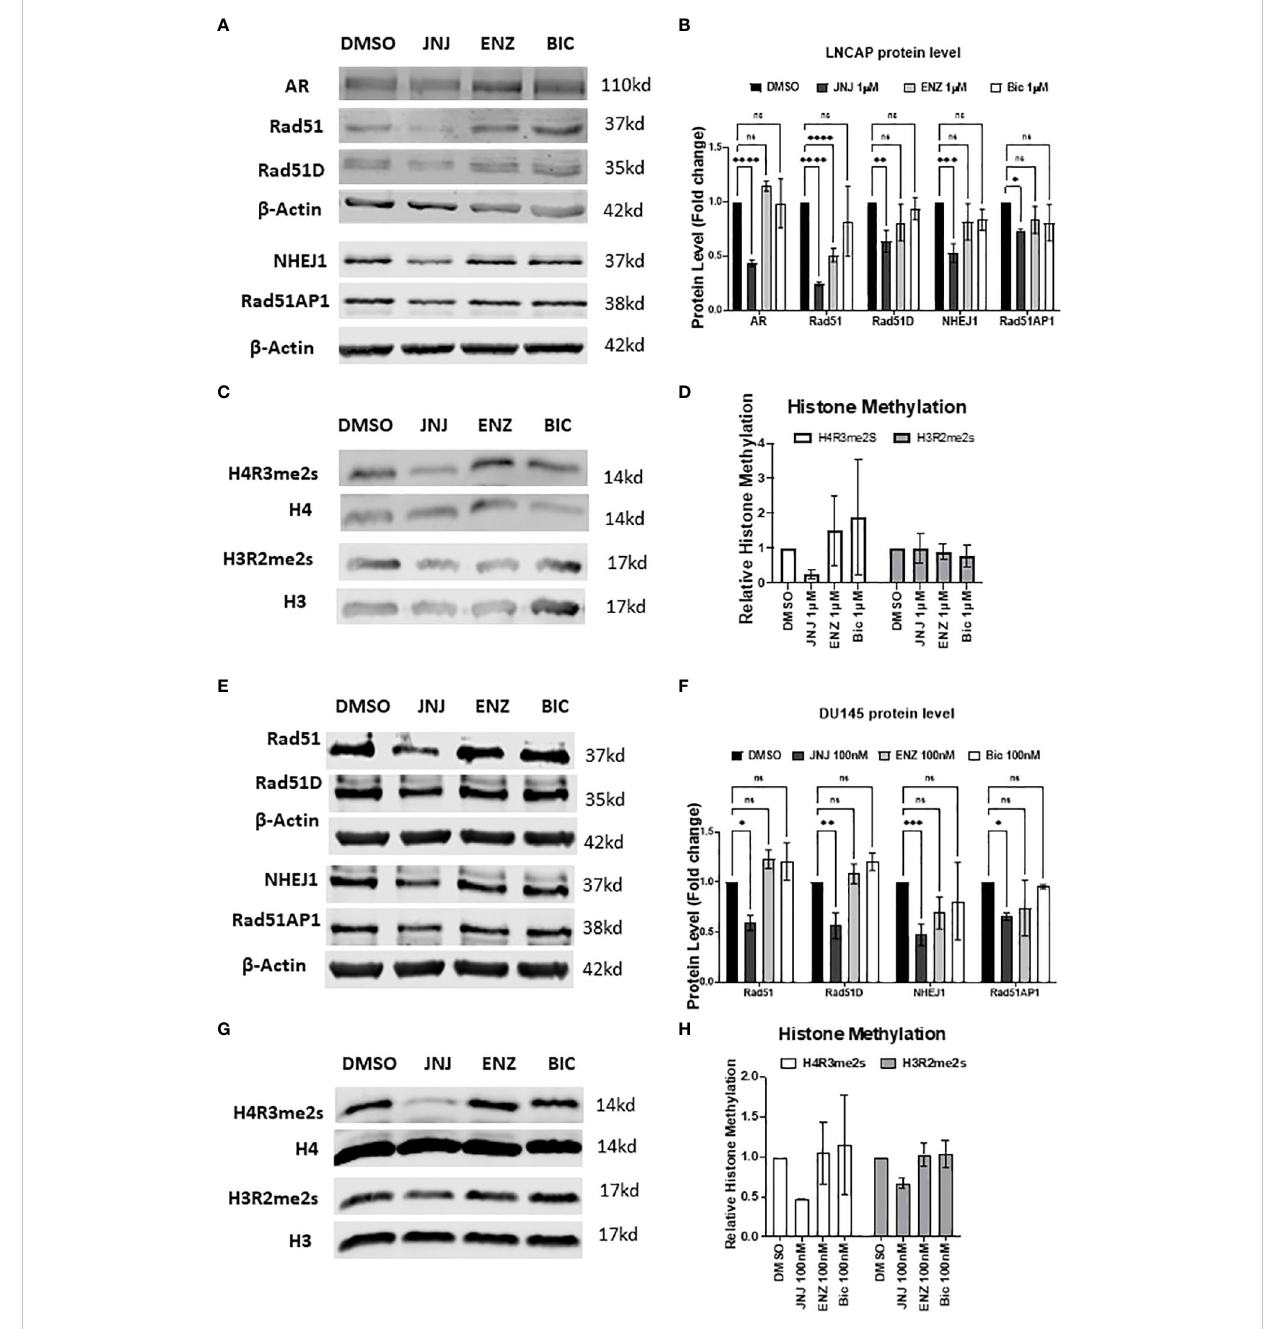
FIGURE 2 JNJ-64619178 targets DNA damage repair proteins expression and epigenetic methylation of histone proteins. (A) Representative western blot images showing the change in DNA damage repair proteins expression level compared with standard ASI, Enzalutamide (Enz), and Bicalutamide (Bic) after 4 days of treatment in LNCaP cells. (B) Histogram showing quanti fi cation of western blots shown in (A) For each biological replication, proteins were normalized to the beta-Actin to calculate the change in protein level after treatment (C) Representative western blot images of histone proteins and their methylation status post-treatment in LNCaP cells. (D) Histogram showing the change in the histone protein methylation post- treatment normalized to the speci fi c histone level, from (C, D) Representative western blot images showing the change in DNA damage repair proteins expression level compared with standard ASI, Enzalutamide (Enz) and Bicalutamide (Bic) after 4 days of treatment in DU145 cells. (E) Histogram showing quanti fi cation of western blots shown in (D) For each biological replication, proteins were normalized to the beta-Actin to calculate the change in protein level after treatment (F) Representative western blot images of histone proteins and their methylation status post- treatment in DU145 cells. (G) Histogram showing change in the histone protein methylation post-treatment normalized to the speci fi c histone level, from (F) For statistical analysis one-way ANOVA was performed with the Tukey test for multiple analysis, each bar in (B, D, F, H) are mean of SD of n=3 independent experiments (*P ≤ 0.05; **P ≤ 0.01; ***P ≤ 0.001; ****P ≤ 0.0001; NS, P >